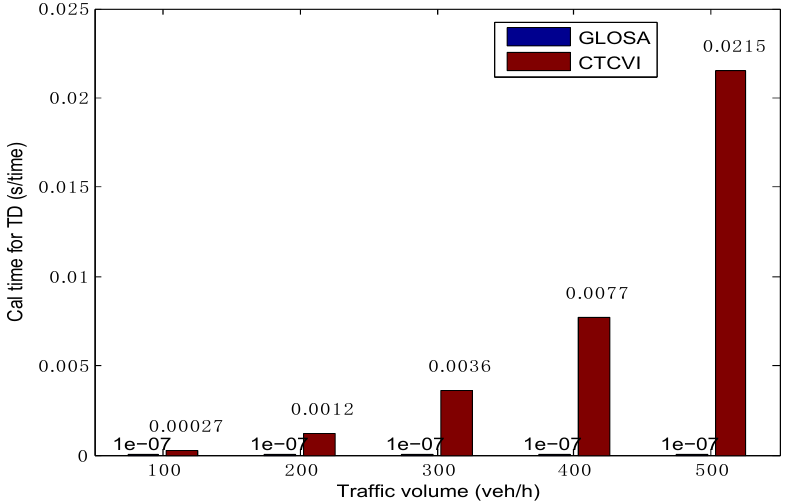
Figure 11. Comparison of calculation time in the optimization of traffic delays.